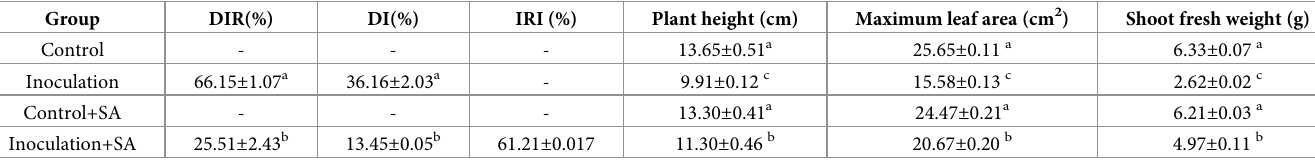
The calculation of DIR and DI was presented in the methods section. DIR: Disease incidence rate; DI: Disease index. Data shown represent mean ± SD (n = 200). The superscript letters indicate significance (Tukey’s HSD test, P <